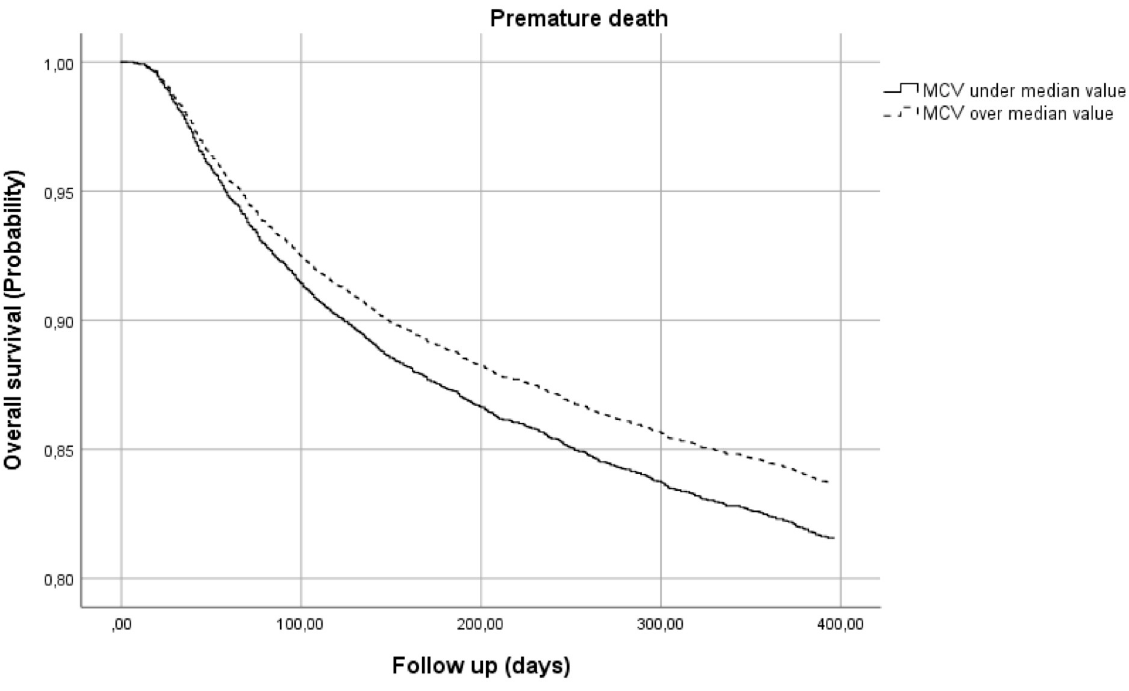
Fig 4. Risk of premature death by mean corpuscular value (MCV).